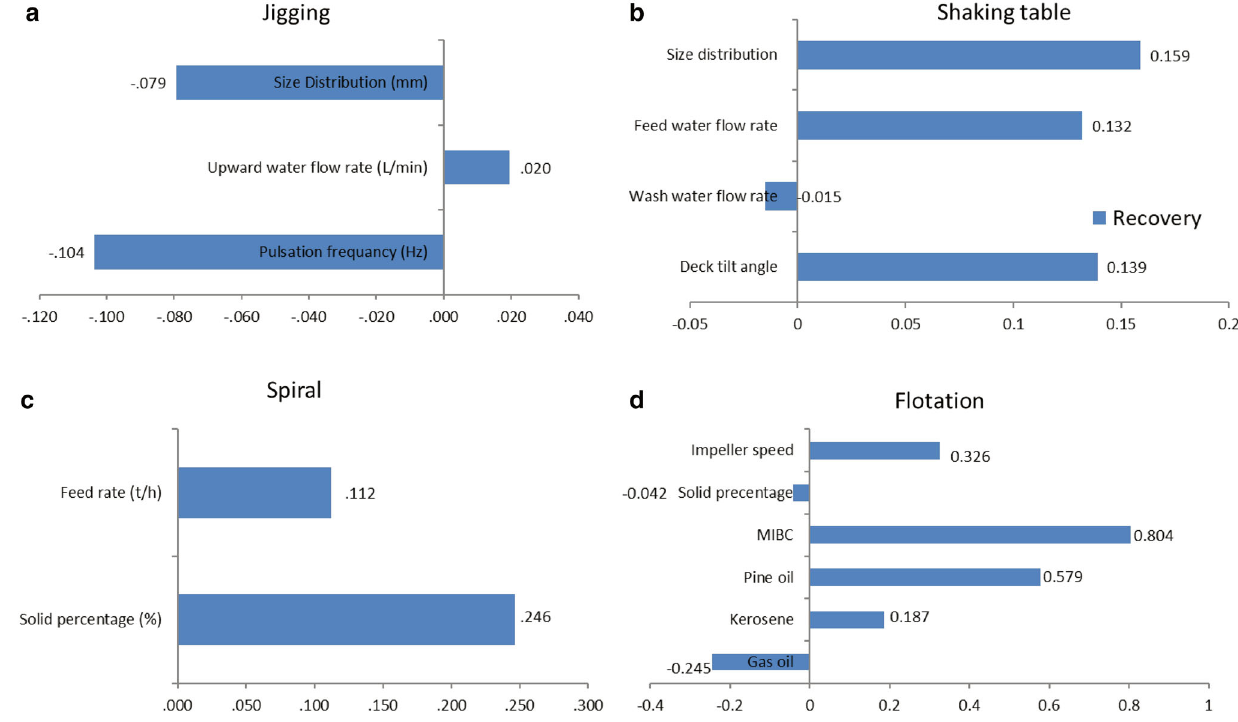
Fig. 2 Pearson correlation assessment between various conditions and their